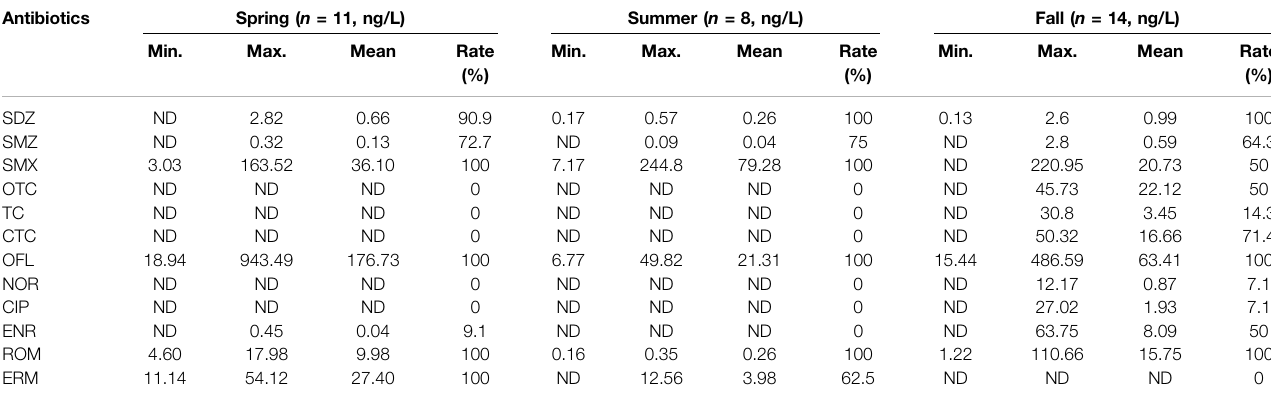
TABLE 1 | Concentration of antibiotics in the surface water of East Dongting Lake. Antibiotics Spring ( n = 11, ng/L)